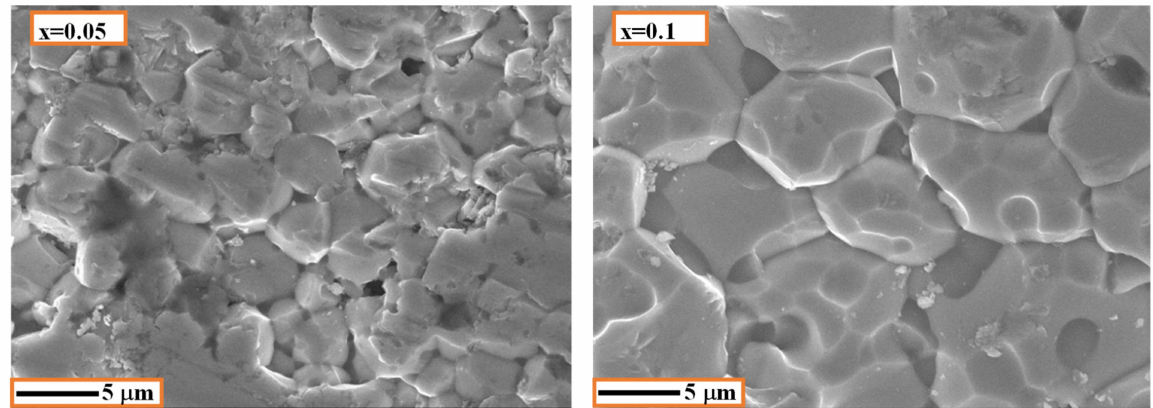
Figure 3. FE-SEM morphology of NSTO ceramics.